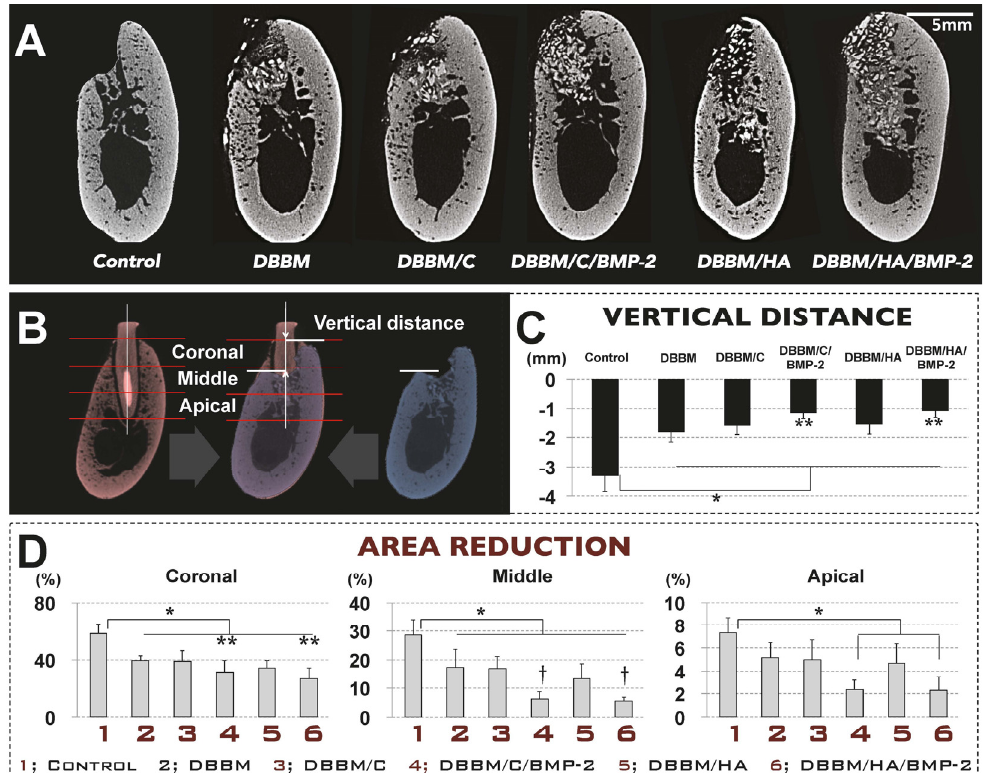
Figure 5. Radiographic analysis: micro-computed tomography of the beagle extraction-socket model. ( A ) Buccolingual cross-sectional view of the augmented sites after eight weeks of healing (scale bar = 5mm). The alveolar ridge resorption was more pronounced in the buccal and coronal regions than in the lingual and apical regions; ( B ) Schematic indicating the locations of the various measurements, using superimposing central-most sagittal views of experimental site (extracted and/or grafted) and pristine tooth site at the contralateral mandible; ( C ) The reduction of alveolar bone height in the fresh extraction socket was significantly decreased in all of the grafted groups compared to the control group (* p < 0.05). Two augmentation sites that received rhBMP-2 showed a significantly decreased vertical distance compared to the other three grafted groups (** p < 0.05); ( D ) All grafted groups showed decreases in the reduction of the alveolar bone area compared to the control group (* p < 0.05). These dimensional reductions of the alveolar ridge at sites that received rhBMP-2 were also significantly decreased than in the other grafted extraction-socket groups (**, significantly different from groups not treated with rhBMP-2; †, significantly different from the DBBM and DBBM/C groups). DBBM, deproteinized bovine bone mineral; C, absorbable collagen sponge; BMP-2, bone morphogenetic protein-2; HA, hydroxyapatite-coated collagen.